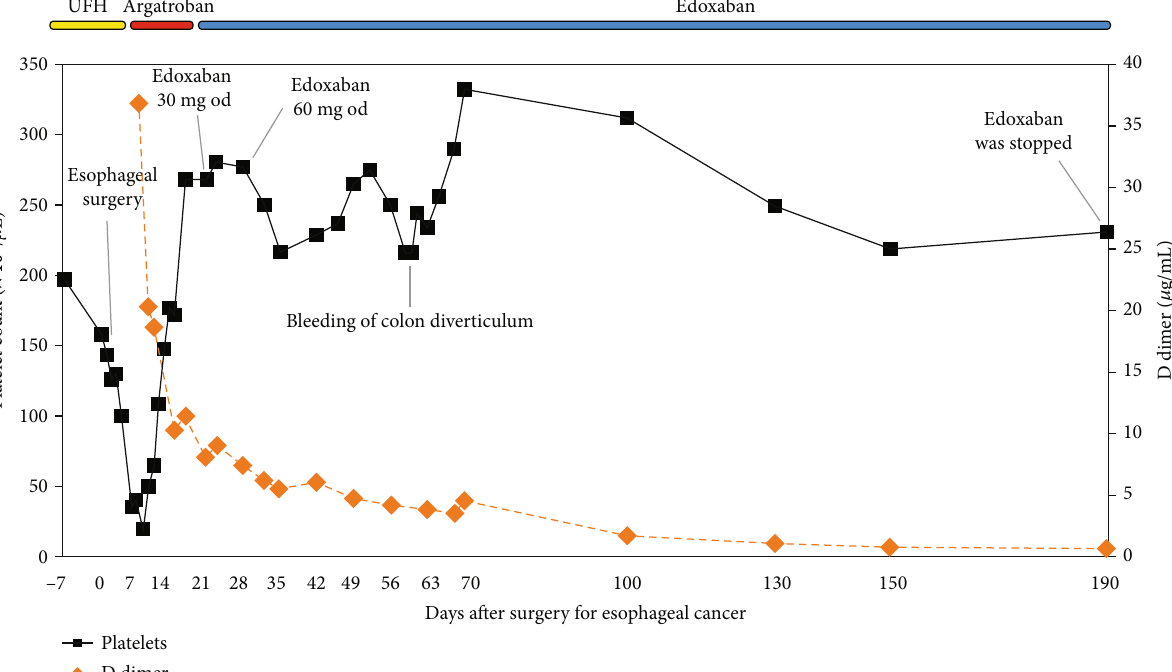
Figure 2: Platelet count and D-dimer value during the administration of anticoagulants in a patient with heparin-induced thrombocytopenia after surgery for esophageal cancer. UFH: unfractionated